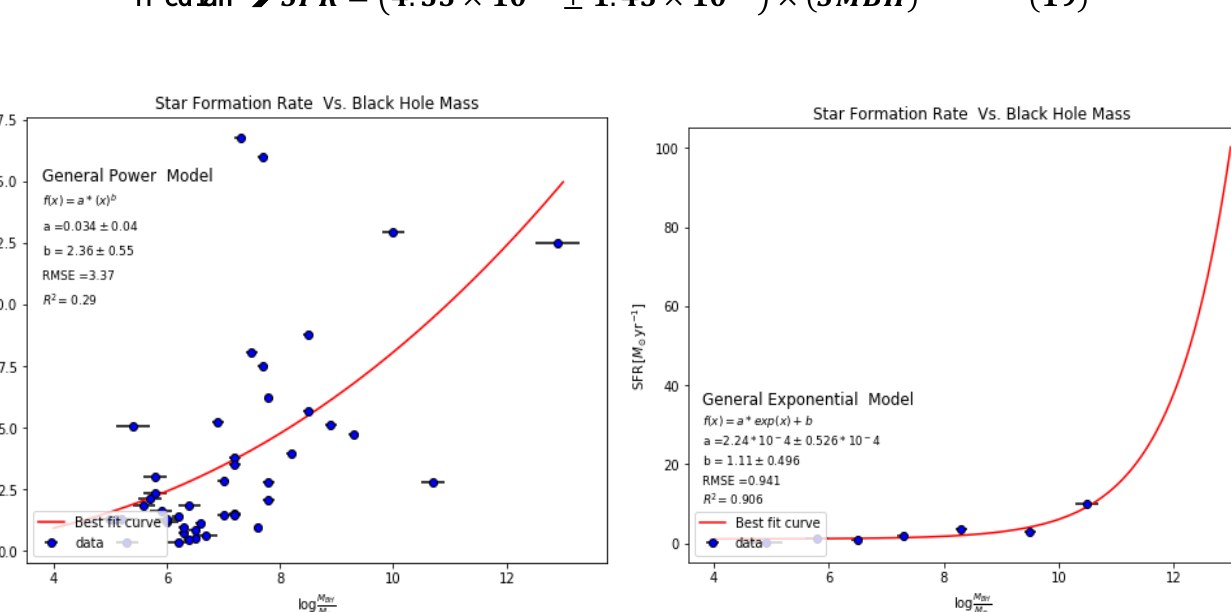
Fig. 6: The correlation between the SMBH & SFR for seyfert2 galaxies using exponential regression, where (a) for all samples, (b) median